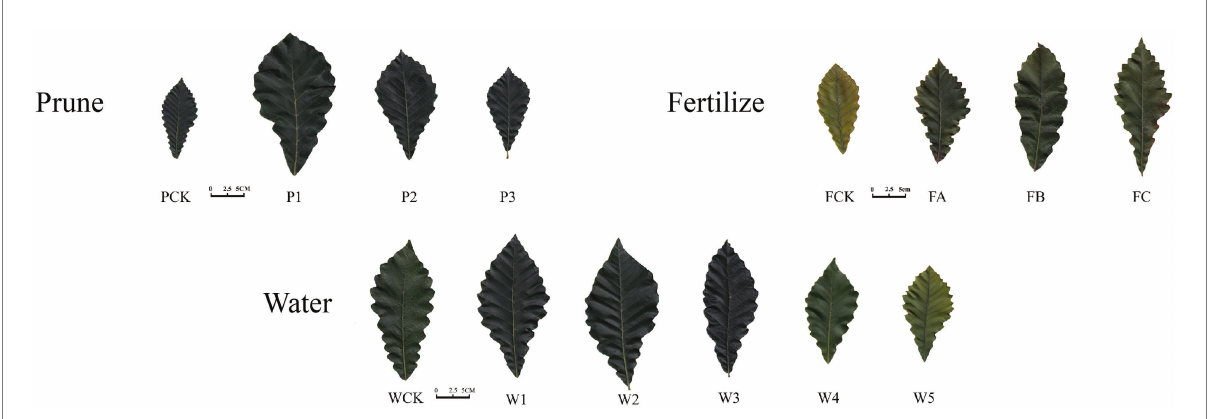
FIGURE 1 Morphological change in Quercus mongolica leaves under different cultivation measures. Prune is pruning, Fertilize is fertilization, and Water is